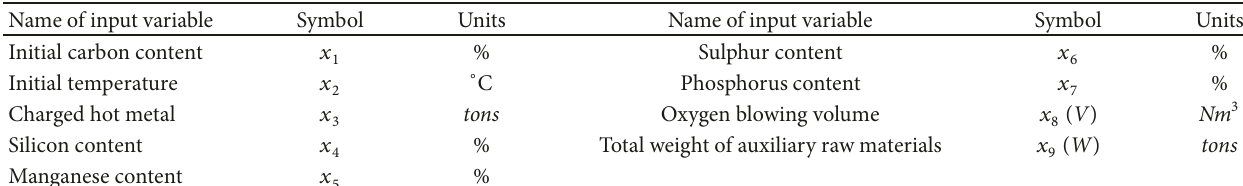
Table 1: Independent input variables of prediction